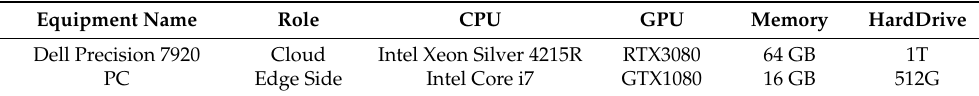
Table 1. Parameter specifications for cloud-based and edge-based Table 1 . Parameter specifications for cloud-based and edge-based devices